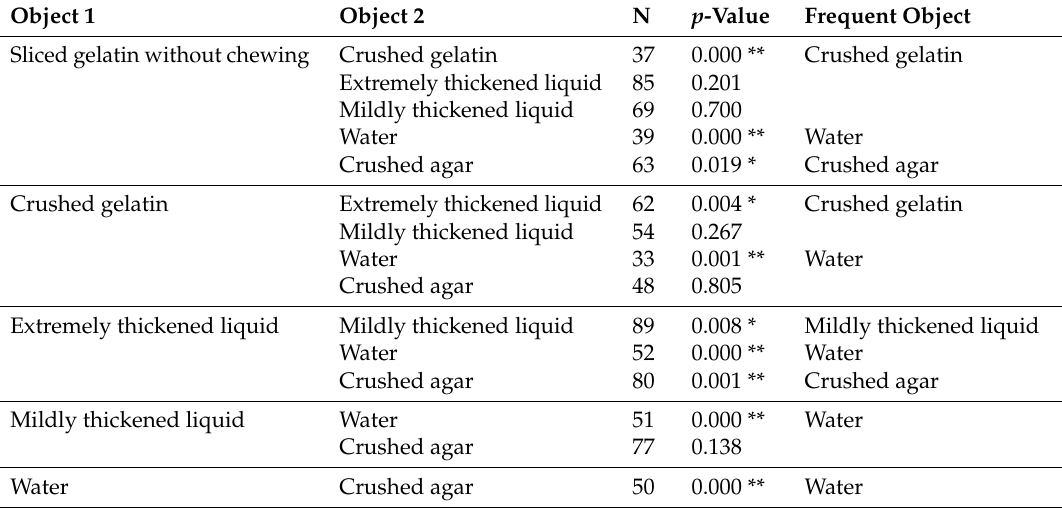
Table 4. Di ff erences in the frequency of aspiration or penetration among food types.